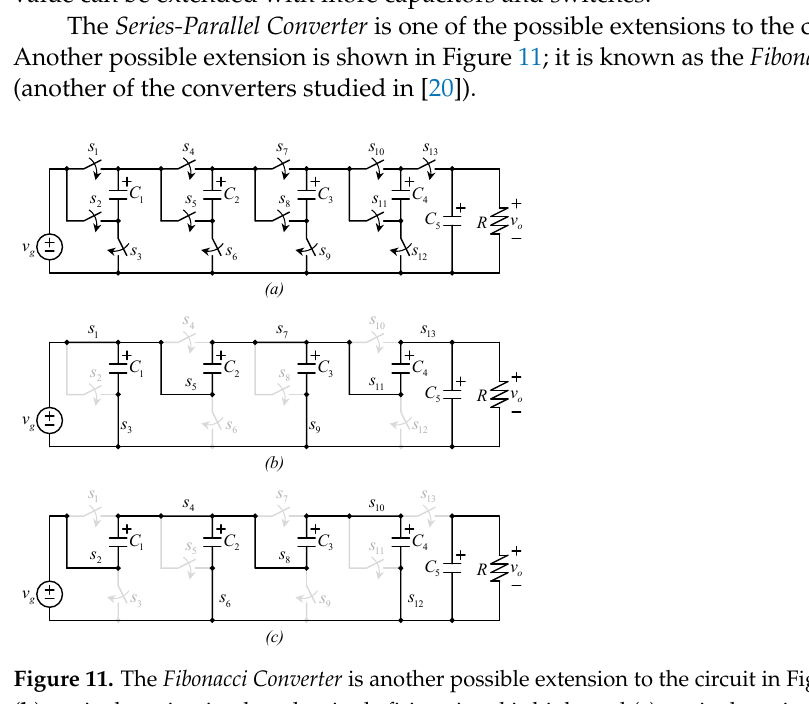
Figure 10. The Series-Parallel Converter and their equivalent switching states, ( a ) topology, ( b ) equiv- alent circuit when capacitors are in parallel, and ( c ) equivalent circuit when capacitors are in series. This converter, which is the Series-Parallel Converter , multiplies the input voltage for a certain value. In the case of Figure 10, the input voltage is multiplied by five, and this value can be extended with more capacitors and switches.